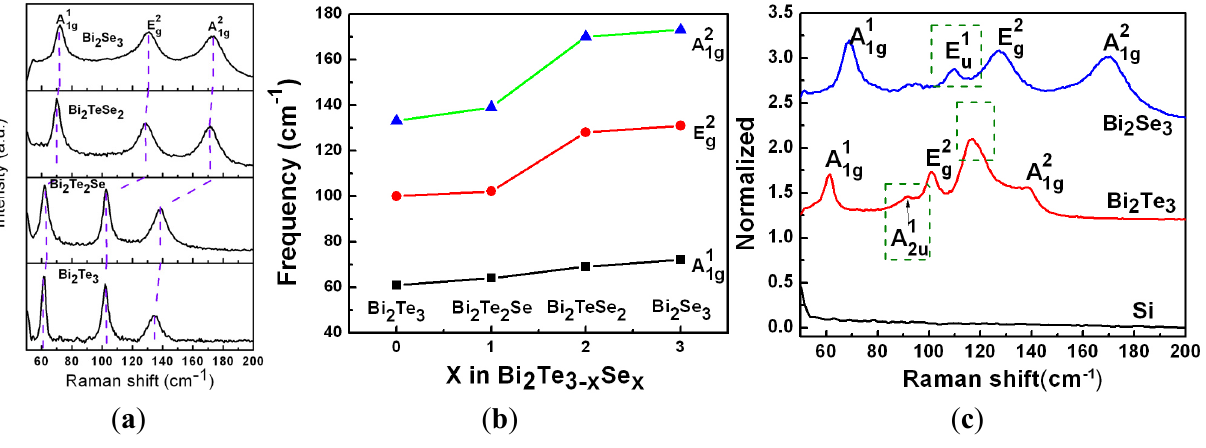
Figure 6. ( a ) Raman spectra of four compounds excited at 785 nm. ( b ) The dependence of Raman peak position on stoichiometric ratio. ( c ) Observation of IR-active vibrational modes in Raman spectra excited at 785 nm. The dashed boxes indicate the peaks of those IR-active